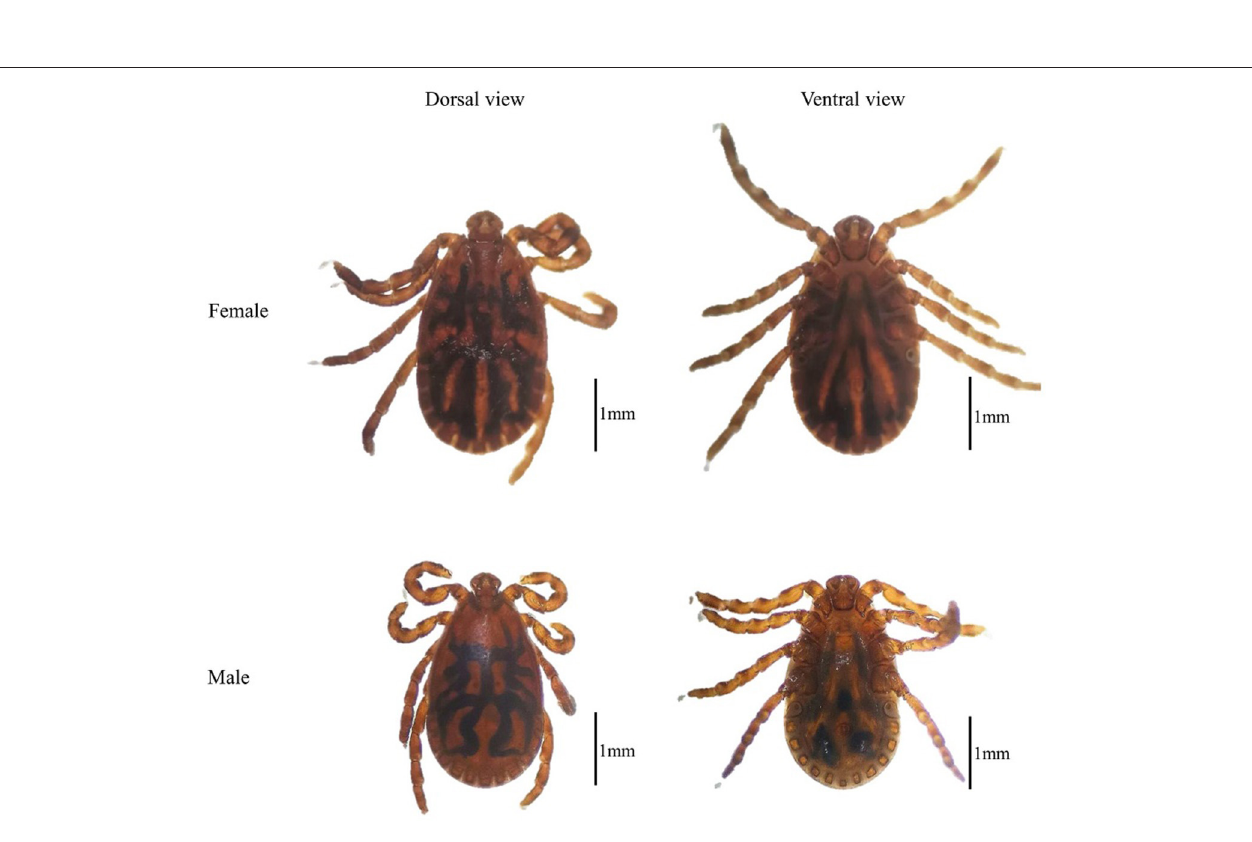
FIGURE 2 | The dorsal view and ventral view of Haemaphysalis qinghaiensis